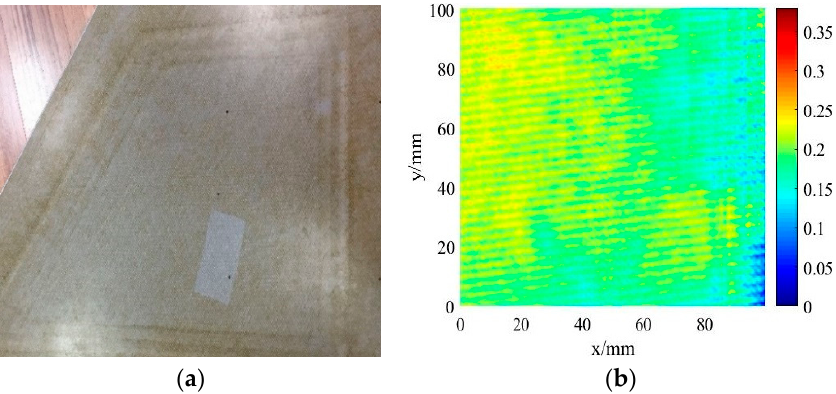
Figure 10. Before test. ( a ) Undamaged specimen, ( b ) Eddy current testing